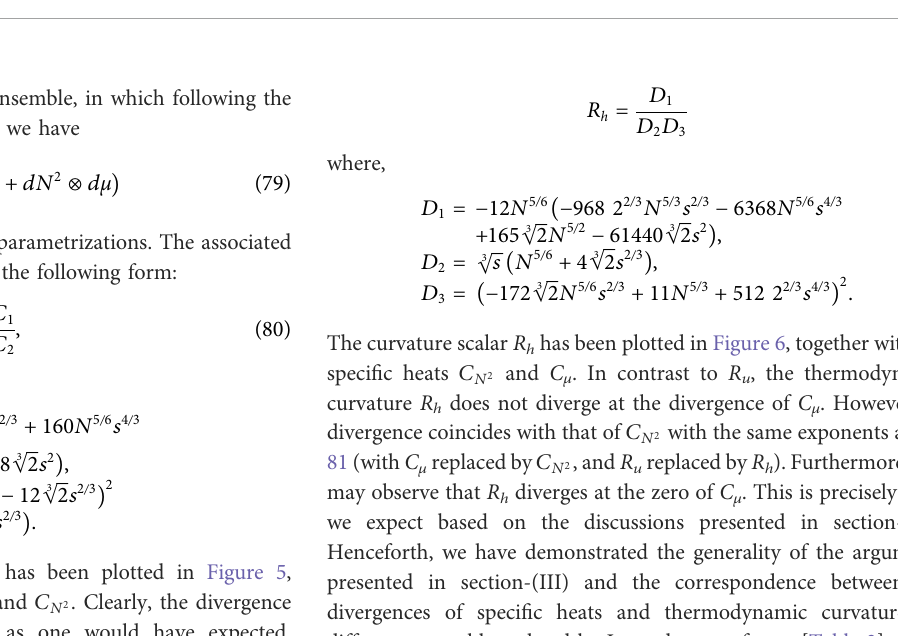
FIGURE 5 Plot of thermodynamic curvature R u together with the speci fi c heats C N 2 and C μ as a function of entropy density s